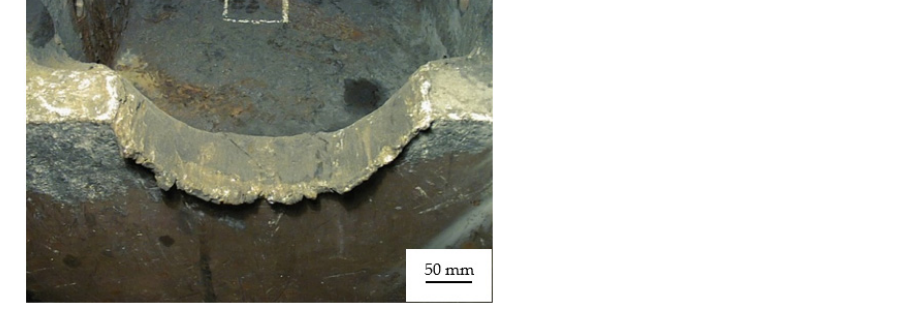
Figure 6. The shape of the material flows that appear in the active area of the trimming dies made of steel K105.